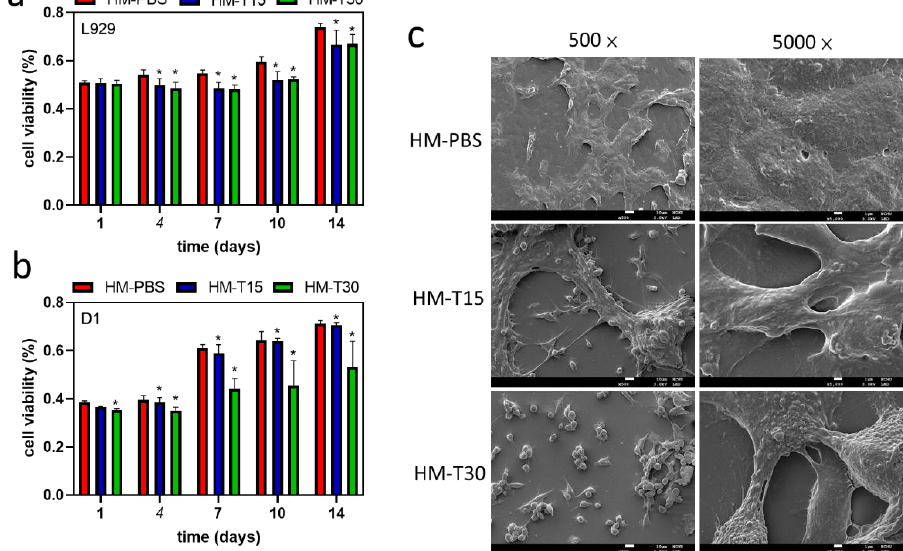
Figure 7. Proliferation of the hydrogel-regenerated membrane in contact with L-929 ( a ) and D1 ( b ) cells for 1, 4, 7, 10, and 14 days. One-way ANOVA, * p < 0.05 compared with the HM group at each time point. ( c ) Images of cell attachment on the hydrogel membrane in contact with D1 cells for 1 day.